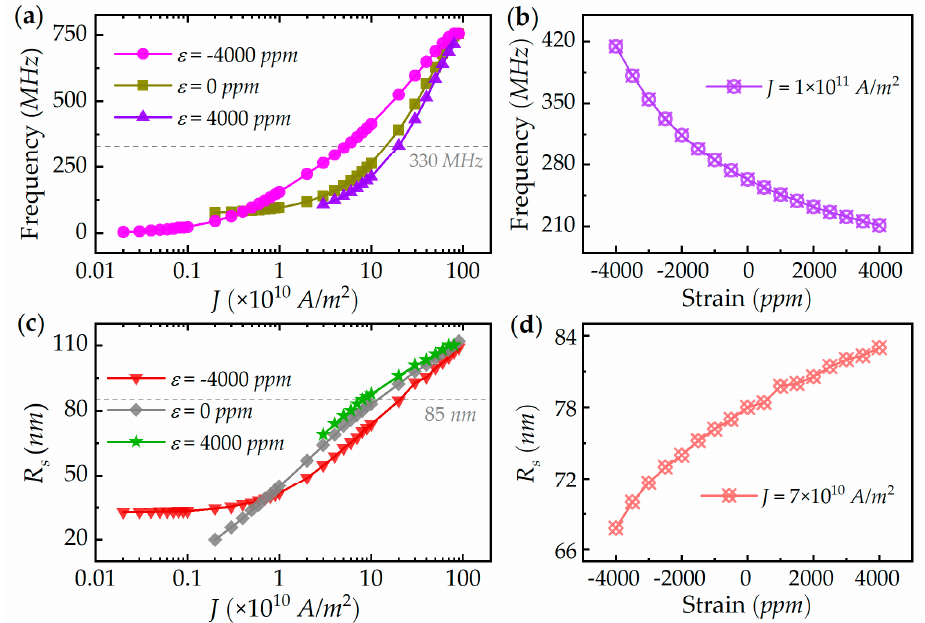
Figure 3. ( a ) Current-dependent oscillation frequency at different piezostrains. ( b ) Piezostrain-dependent oscillation frequency at a fixed current density of J = 1 × 10 11 A/m 2 . ( c ) Current-dependent oscillation amplitude at different piezostrains. ( d ) Piezostrain-dependent oscillation amplitude at a fixed current density of J = 7 × 10 10 A/m 2 .